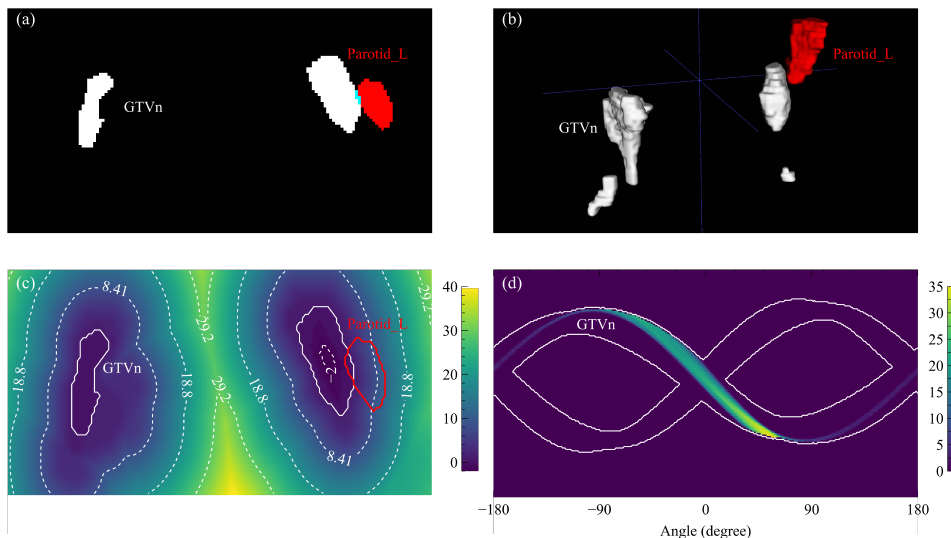
Figure 1. Distance and angle maps based on example GTVn and Parotid_L structures. ( a ) One axial slice of the structure masks (white: GTVn, red: Parotid_L) with the overlap region highlighted by blue. ( b ) The rendered three-dimensional structures. ( c ) One axial slice of the GTVn distance map with annotated contour lines and the Parotid_L contour. ( d ) One slice of the Parotid_L angle map masked by the GTVn sinogram edges (white